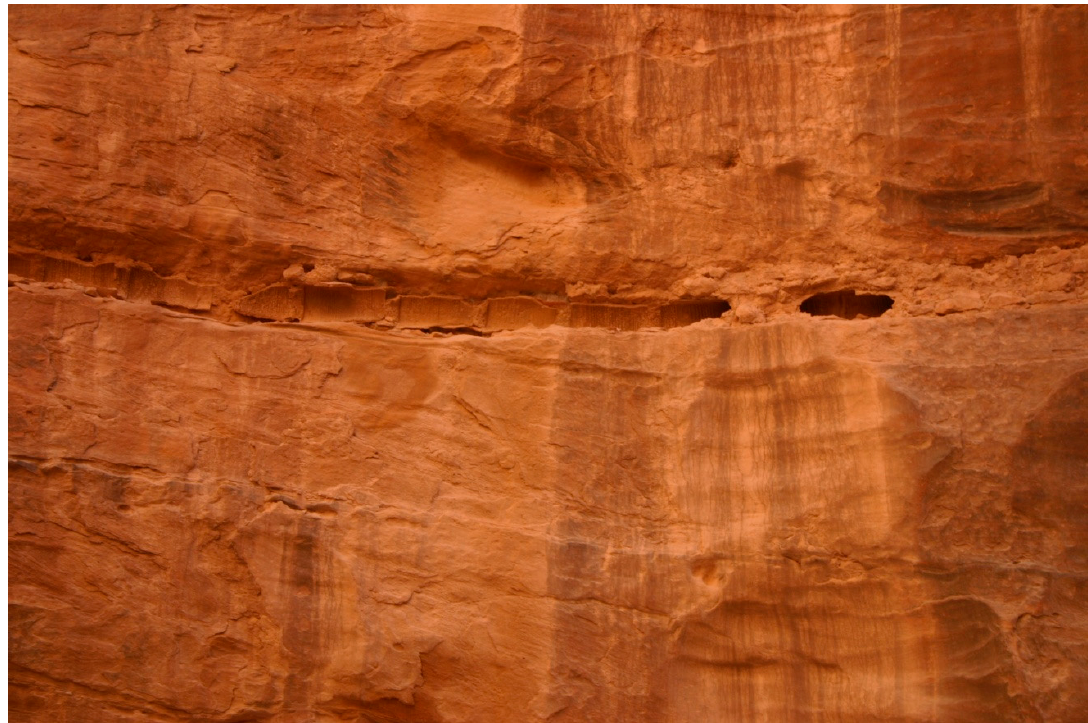
Figure 8. Elevated Outer Siq pipelines located ~6 m above the current site surface. These pipelines lead to an extension of the Siq pipeline to the city center. Several meters below the current site surface is the original paved floor of the area in front of the Treasury.